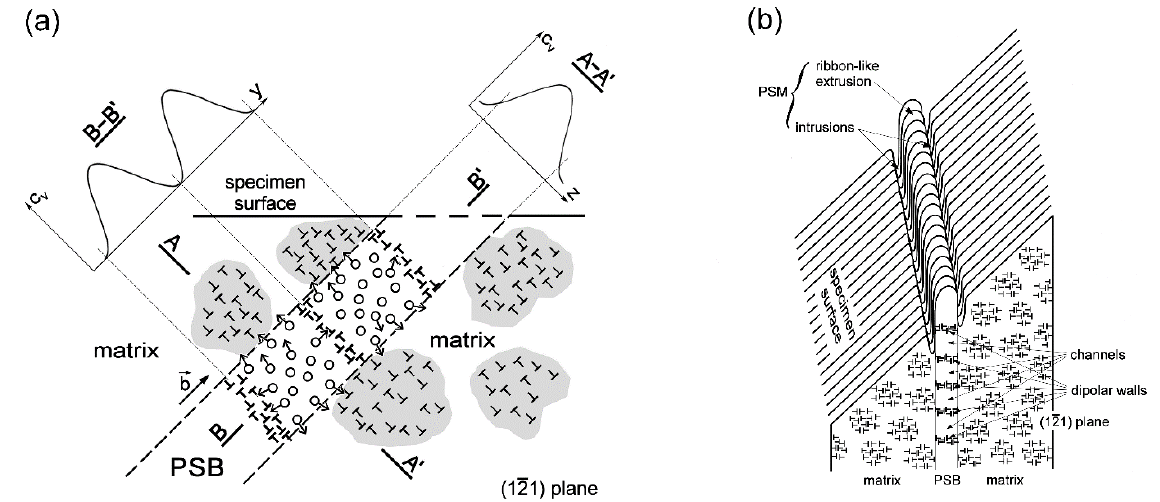
Figure 11. Schematics of vacancy formation and migration in PSB ( a ) and surface relief formation at egressing PSB ( b ).